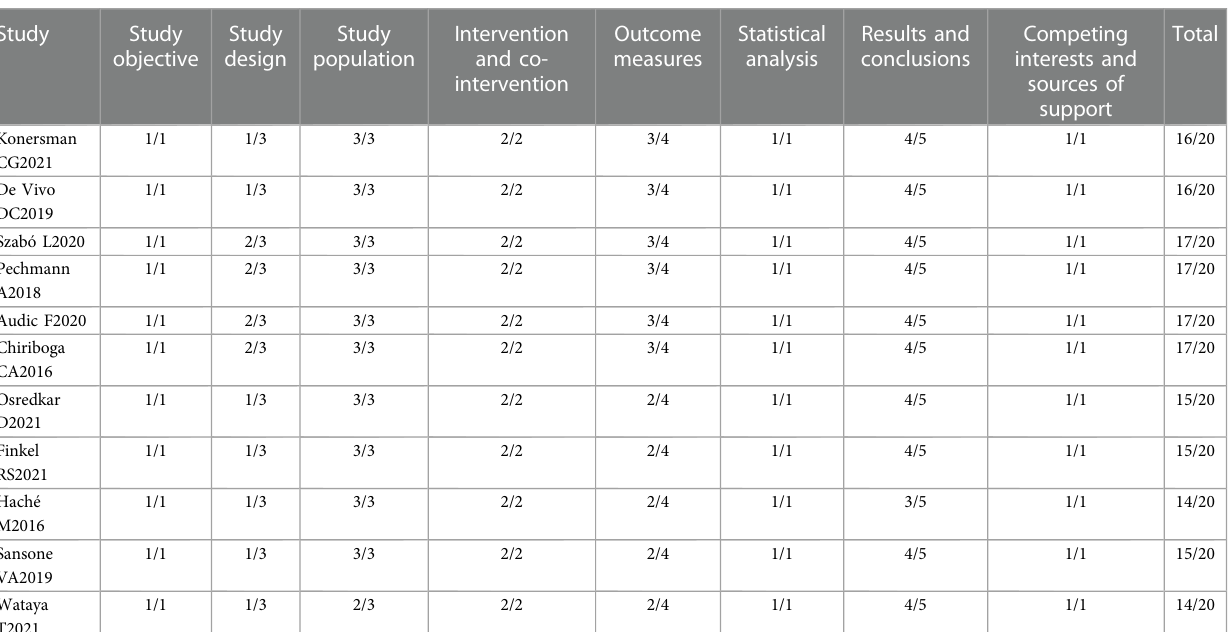
TABLE 2 Quality assessment and risk of bias of included case series (IHE).